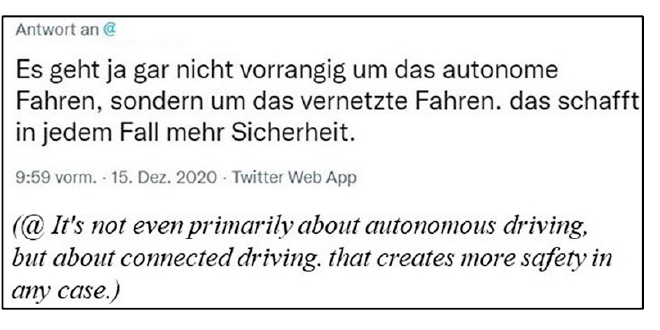
Figure 9. Statement about safety increase from autonomous and connected driving.